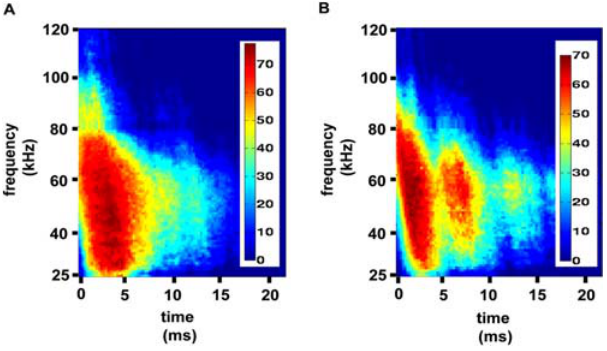
Figure 4. Spectrograms of the weighted support vectors on each side of the hyperplane. The color bars are in dB. (A) The apple spectrograms used as support vectors added up according to their weights. (B) Same as A for corn. Examining the two weighted spectrograms, the idea of the support vectors, being the most difficult data points to separate in the limits of the data set, becomes clearer.